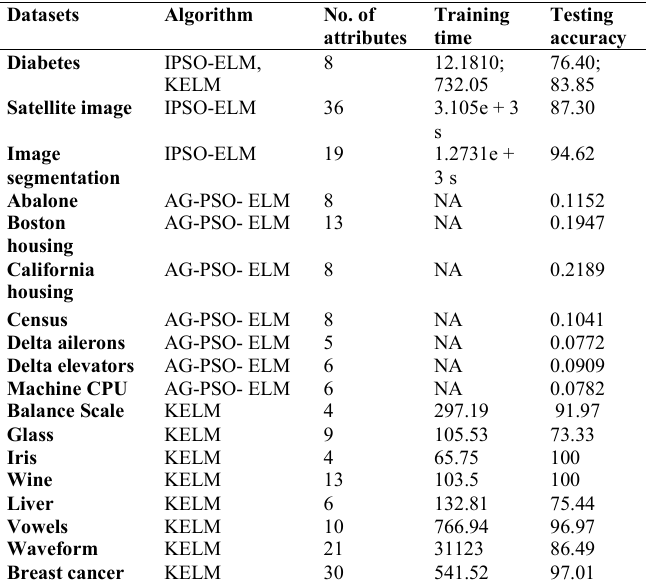
Table 2. Algorithm accuracy of the suggested techniques in the aspect of datasets